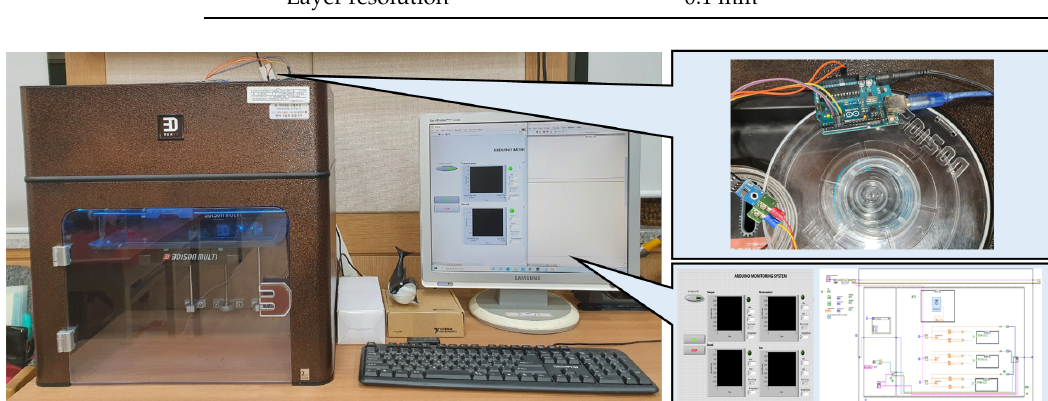
Figure 3. The experimental set-up for the data acquisition and process